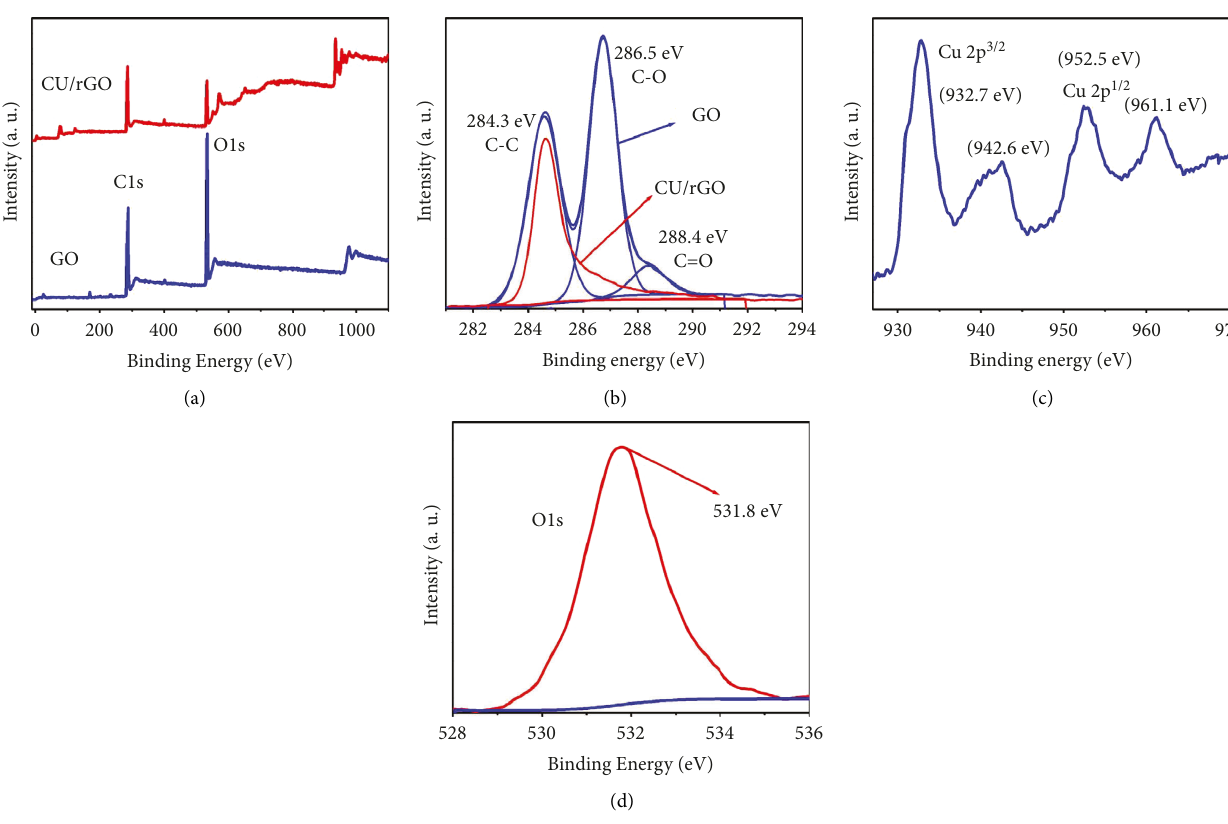
Figure 3: XPS spectra of GO and Cu/rGO: (a) survey; (b) C1s; (c) Cu 2p; (d) O1s.